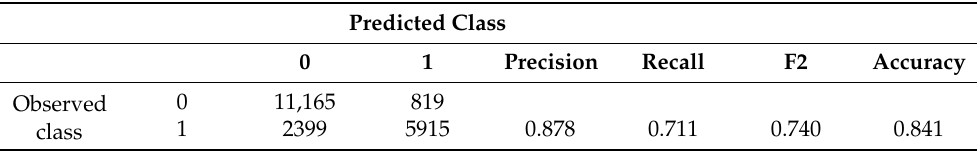
Table 5. Confusion matrix for RF-US model with the validation set.